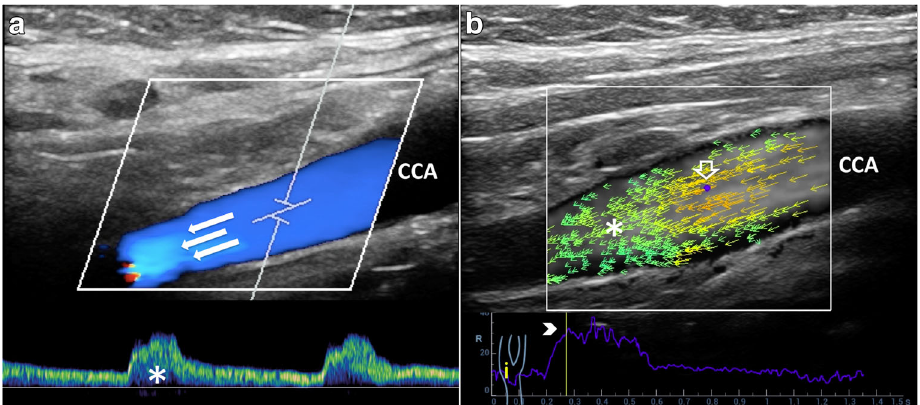
Fig. 4 Laminar flow assessment. a ) CD and PW showing a flow pattern with parabolic profile ( arrows ) and minor spectral broadening (*), respectively. b ) VFI at the peak systole shows the maximum velocity vectors. Low- velocity vectors (*) of the previous diastole. Maximum velocity point ( void arrow ). Yellow line ( arrowhead ): the moment the VFI frame was acquired. CCA = Common carotid artery